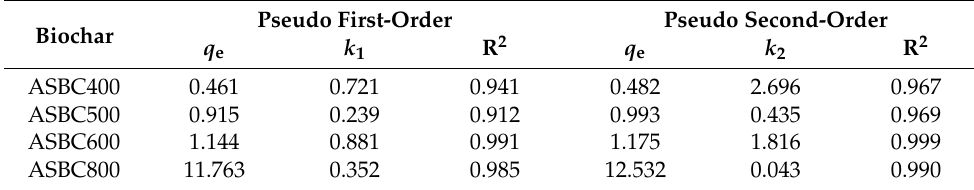
Figure 5. Pseudo-first-order ( a ) and pseudo-second-order ( b ) adsorption kinetic modelling results. Table 2. Adsorption kinetic parameters.